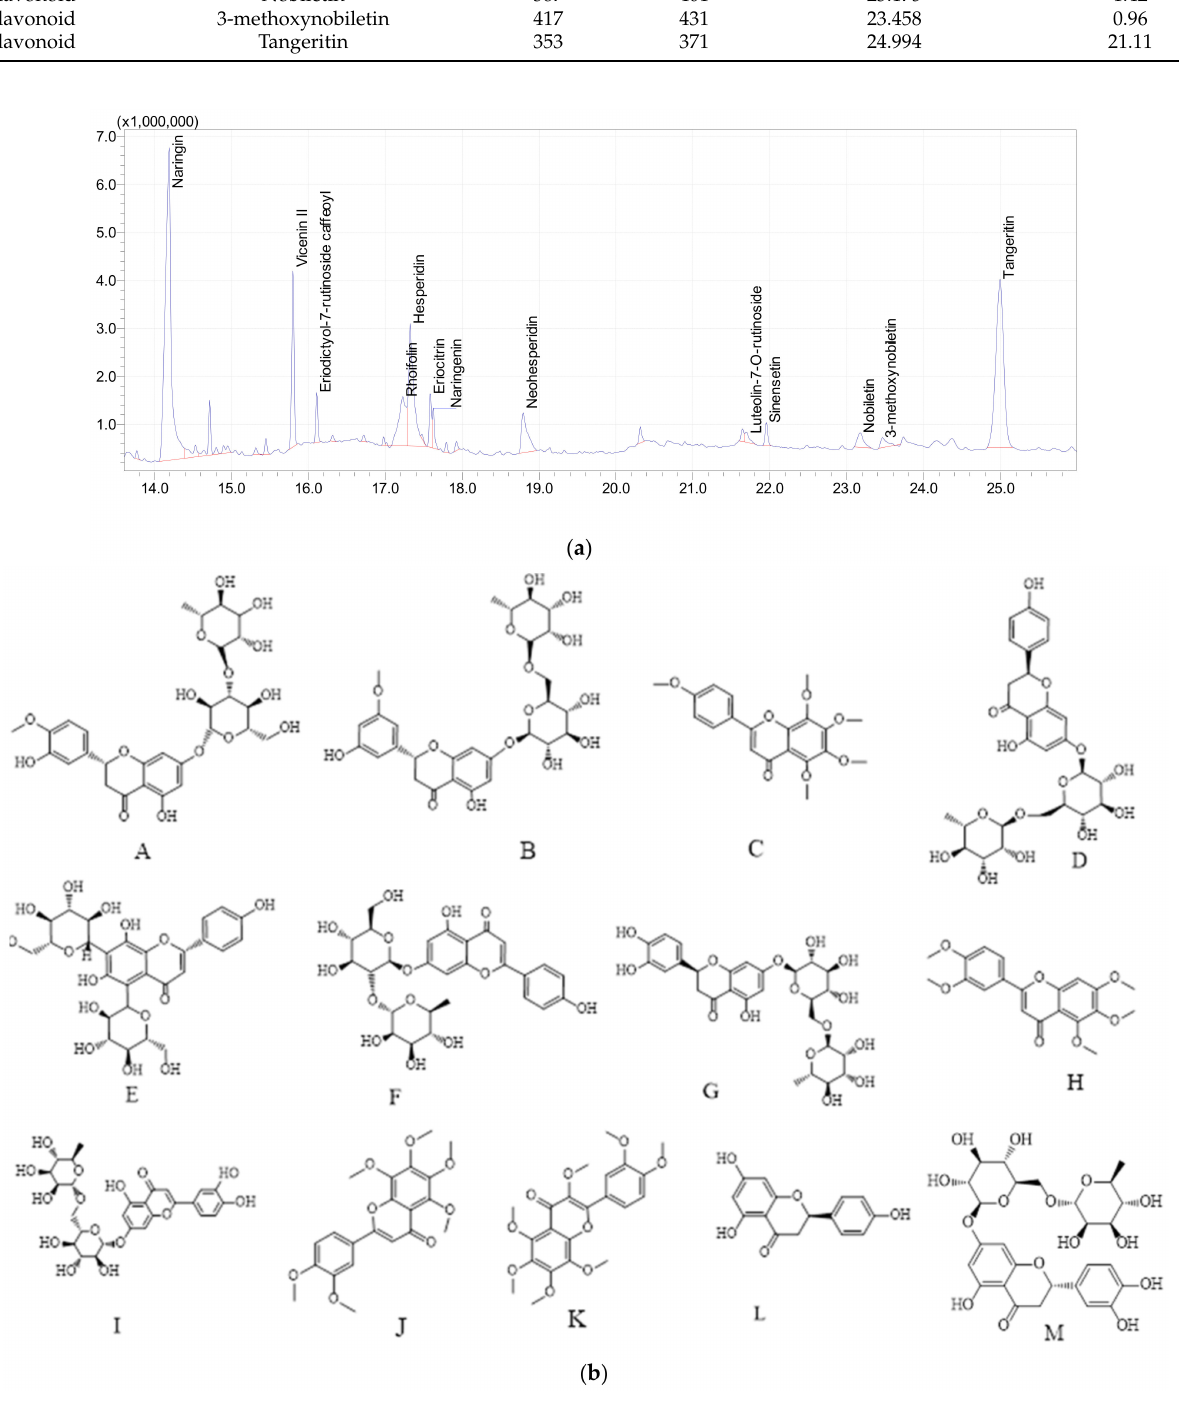
Figure 2. ( a ). Phenolic compounds of C. sinensis peel powders by LC-MS/MS. ( b ). Chemical